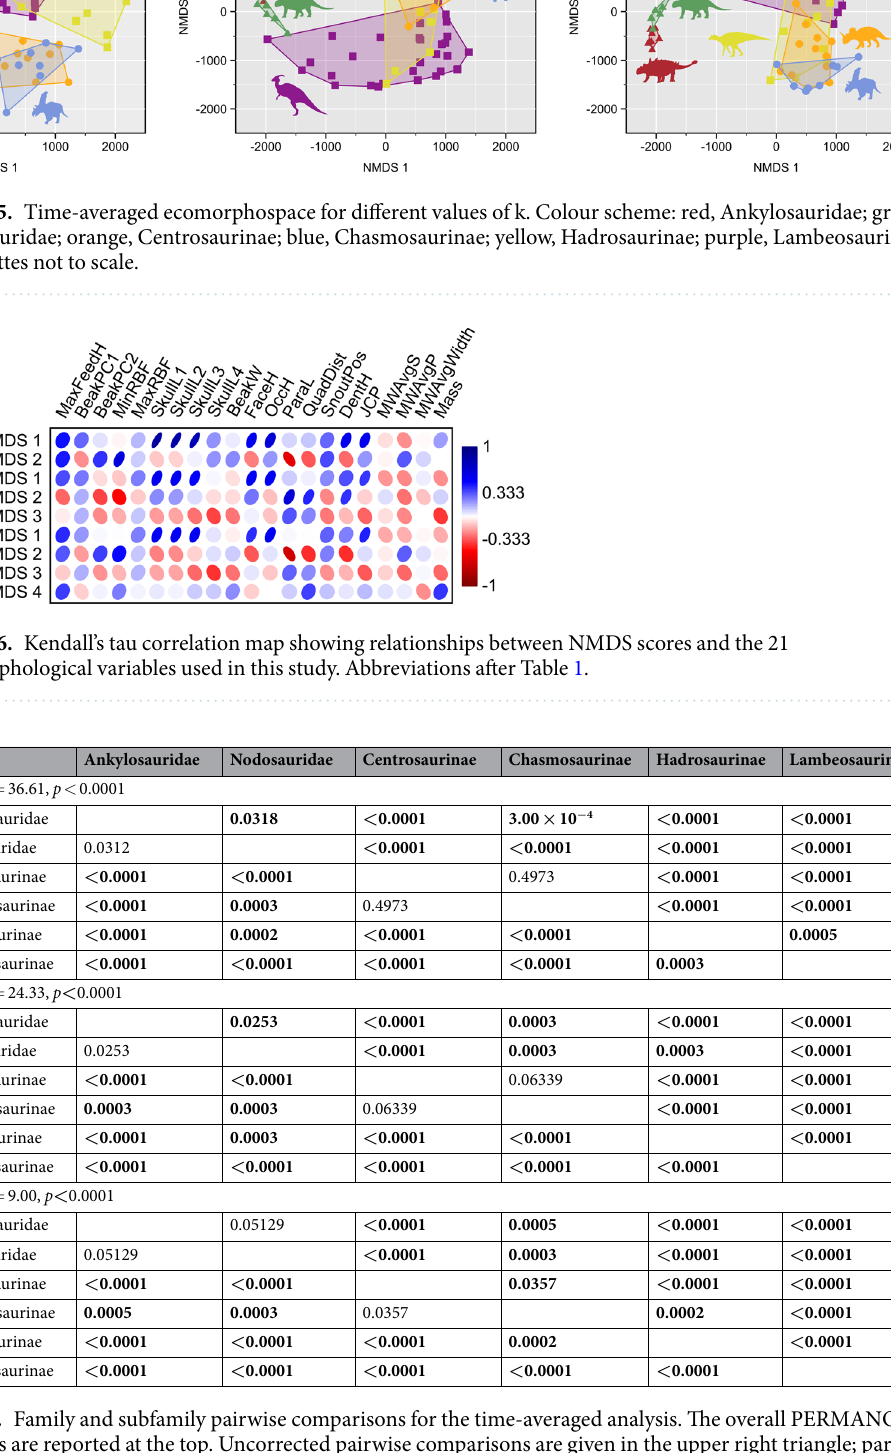
Table 2. Family and subfamily pairwise comparisons for the time-averaged analysis. The overall PERMANOVA statistics are reported at the top. Uncorrected pairwise comparisons are given in the upper right triangle; partial Bonferonni corrected pairwise comparisons are given in the lower left triangle (note: differences in significance between tests reflect corrected α -values, not p -values). Significant results are reported in bold